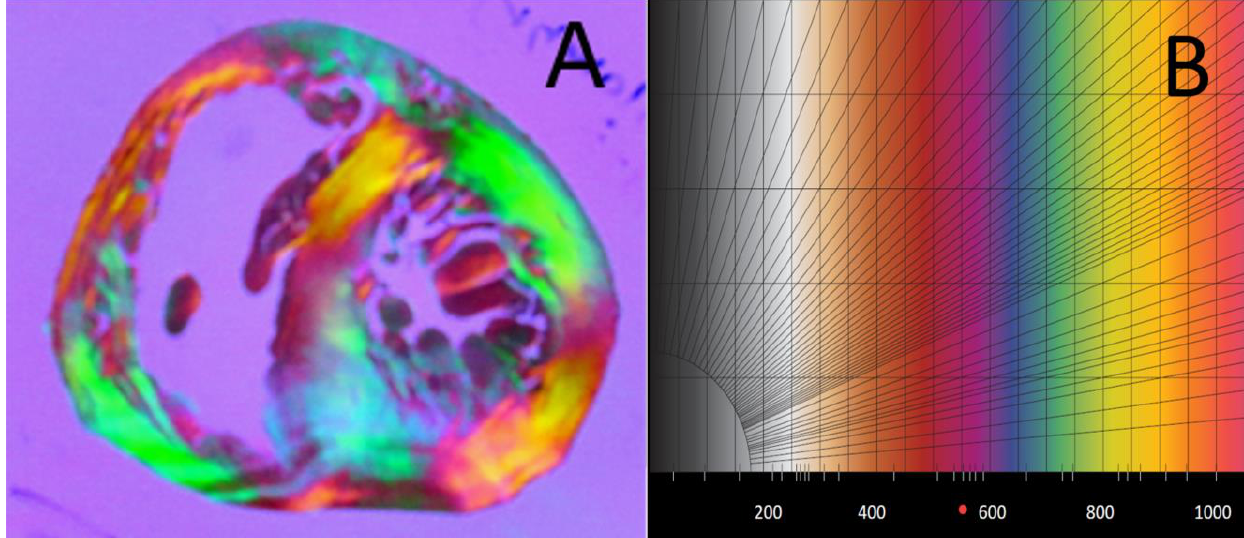
Figure 1. The myocardium embedded in the MMA behaves like a mesh of positive uniaxial crystals of myosin. ( A ) View of a 500 µm thick slice of a neonatal heart embedded in MMA, imaged between crossed polars with the addition of a full wave plate (path difference 540 nm). ( B ) Michel Levy colour chart from 0 to 1100 nm path difference. The comparison of the colours between A and B makes the visual assessment of the phase difference of the rays passing through the crystal possible.